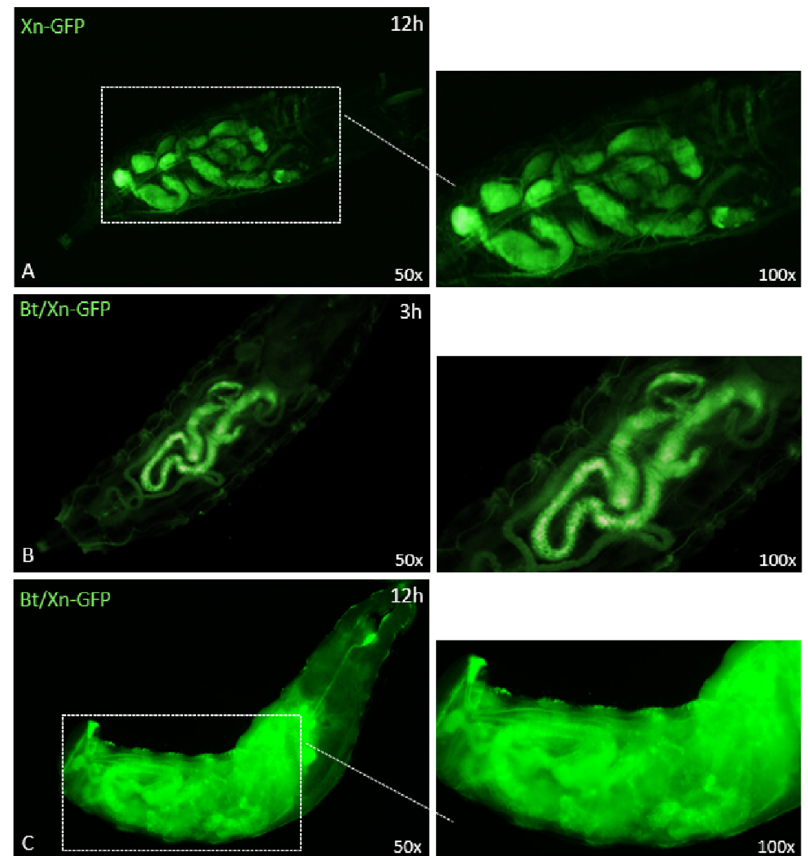
Figure 7. Oral ingestion of X. nematophila -GFP in the presence or absence of pre-treatment with B. thuringiensis (panels A , B and C ). Panel A shows the presence of X. nematophila in the larvae gut after B. thuringiensis ( A – C ). ( A ) shows the presence of X. nematophila in the larvae gut after 12 h of treatment. 12 h of treatment. Panel B shows the presence of X. nematophila in the gut administered with B. ( B ) shows the presence of X. nematophila in the gut administered with B. thuringiensis , 3 h after oral thuringiensis , 3 h after oral intake. Panel C shows that, after 12 h of treatment with B. thuringiensis , intake. ( C ) shows that, after 12 h of treatment with B. thuringiensis , X. nematophila -GFP was no longer X. nematophila -GFP was no longer confined within the gut but reached and spread into the hemocoel confined within the gut but reached and spread into the hemocoel cavity of the larvae. Insets at right cavity of the larvae. Insets at right are enlargements of the micrographs. are enlargements of the